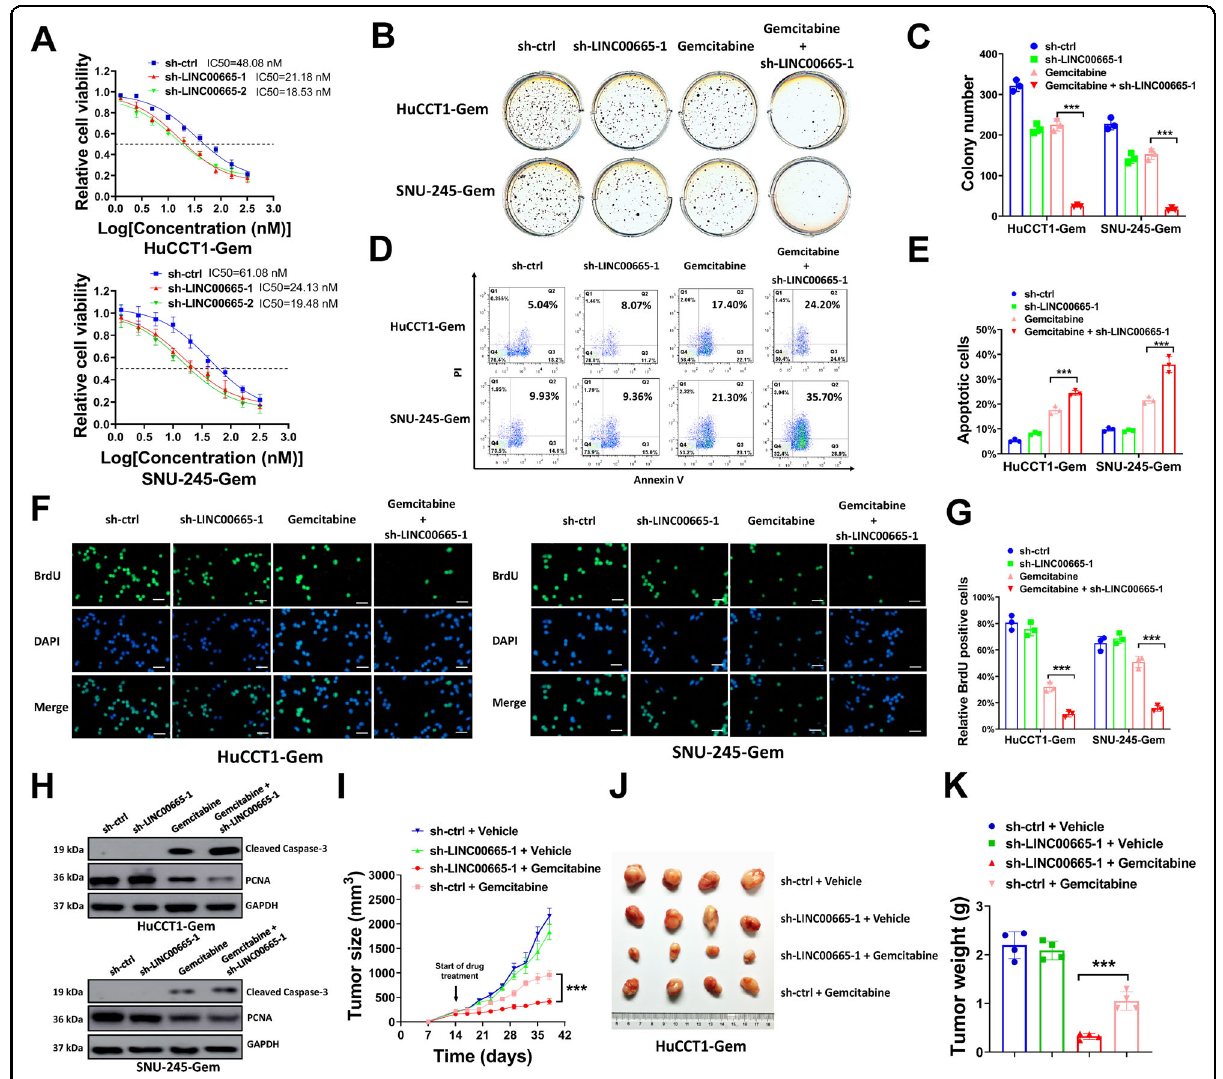
Fig. 2 LINC00665 knockdown impairs gemcitabine tolerance in resistant CCA cells. A HuCCT1-Gem and SNU-245-Gem cells transduced with sh-LINC00665-1, sh-LINC00665-2, or sh-ctrl were seeded in 96-well plates (5000 cells/well) and exposed to 0, 1.25, 2.50, 5.0, 6.25, 10, 20, 40, 80, 160,